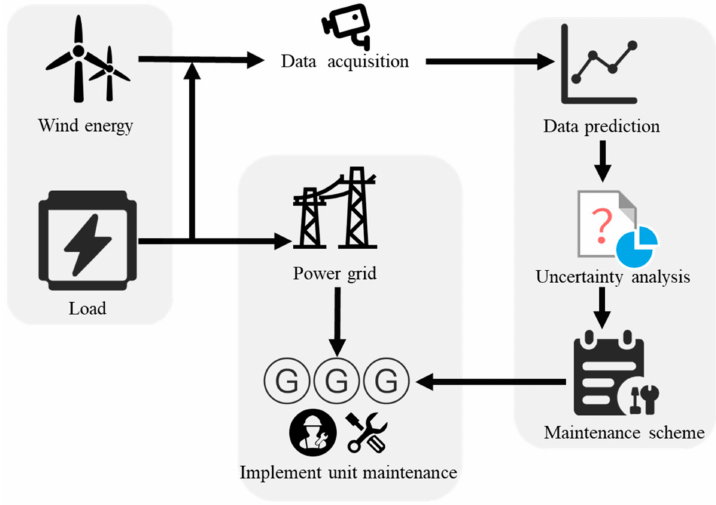
Figure 1. The process of drawing up the unit maintenance